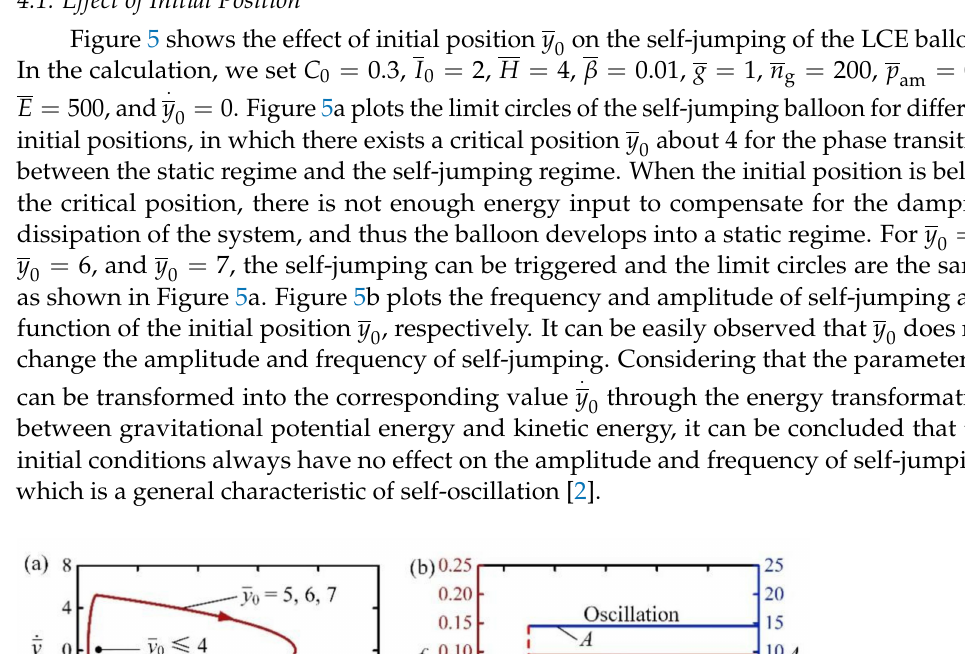
. = 0. ( a ) Limit cycles. ( b ) Frequency and amplitude. There y 0 does not affect the amplitude and frequency of 0